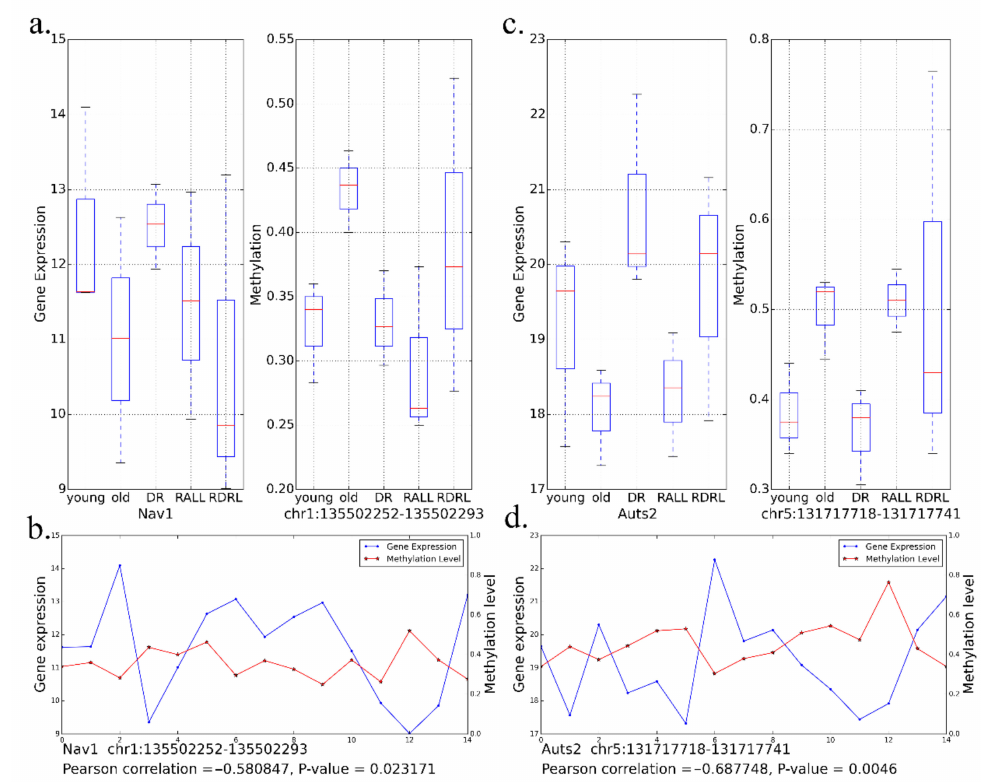
Figure 9. Correlation between gene expression and methylation of Nav1 and Auts2 . ( a ) Gene expression level of Nav1 and methylation level of bin (chr1:135502252–135502293) in five groups; ( b ) correlation of Nav1 expression and bin methylation in all samples; ( c ) gene expression level of Auts2 and methylation level of bin (chr5:131717718-131717741) in five groups; ( d ) correlation of Auts2 expression and bin methylation in all